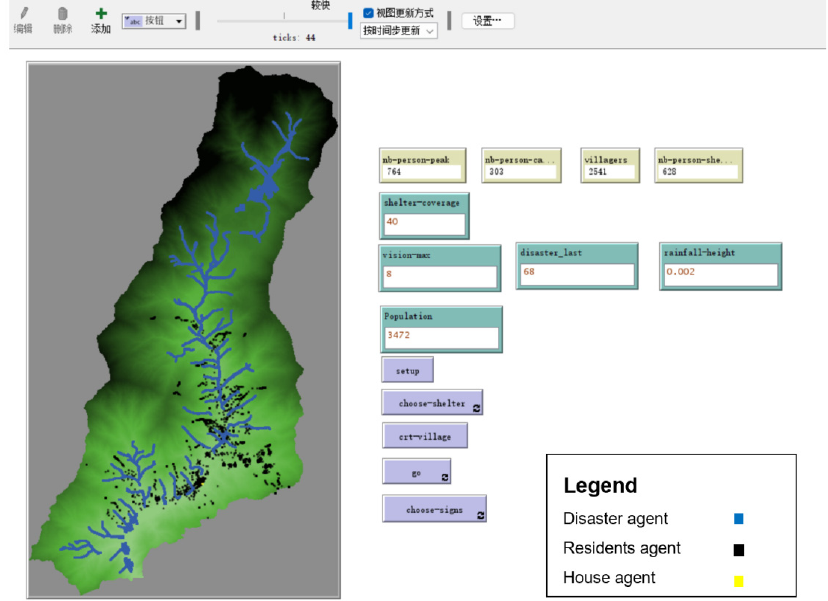
Figure 4. Screenshot of simulation on Netlogo platform.